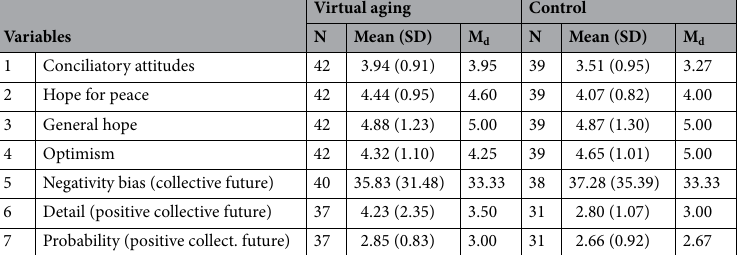
Table 1. Means, standard deviations, and median values of outcome and mediator variables in Study 6. Variables 1–4 are measured on a six-point scale (6 = highest level). Level of detail (word count